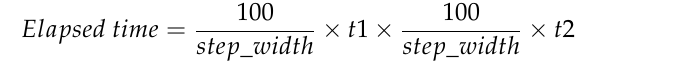
Algorithm 1 Pseudocode of algorithm for Minimizing Model Size